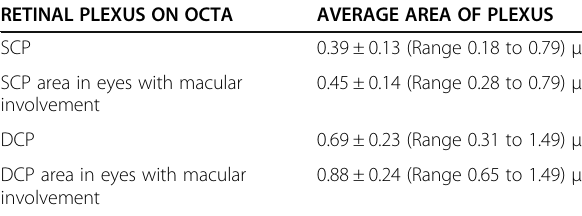
Table 5 SCP-DCP area RETINAL PLEXUS ON